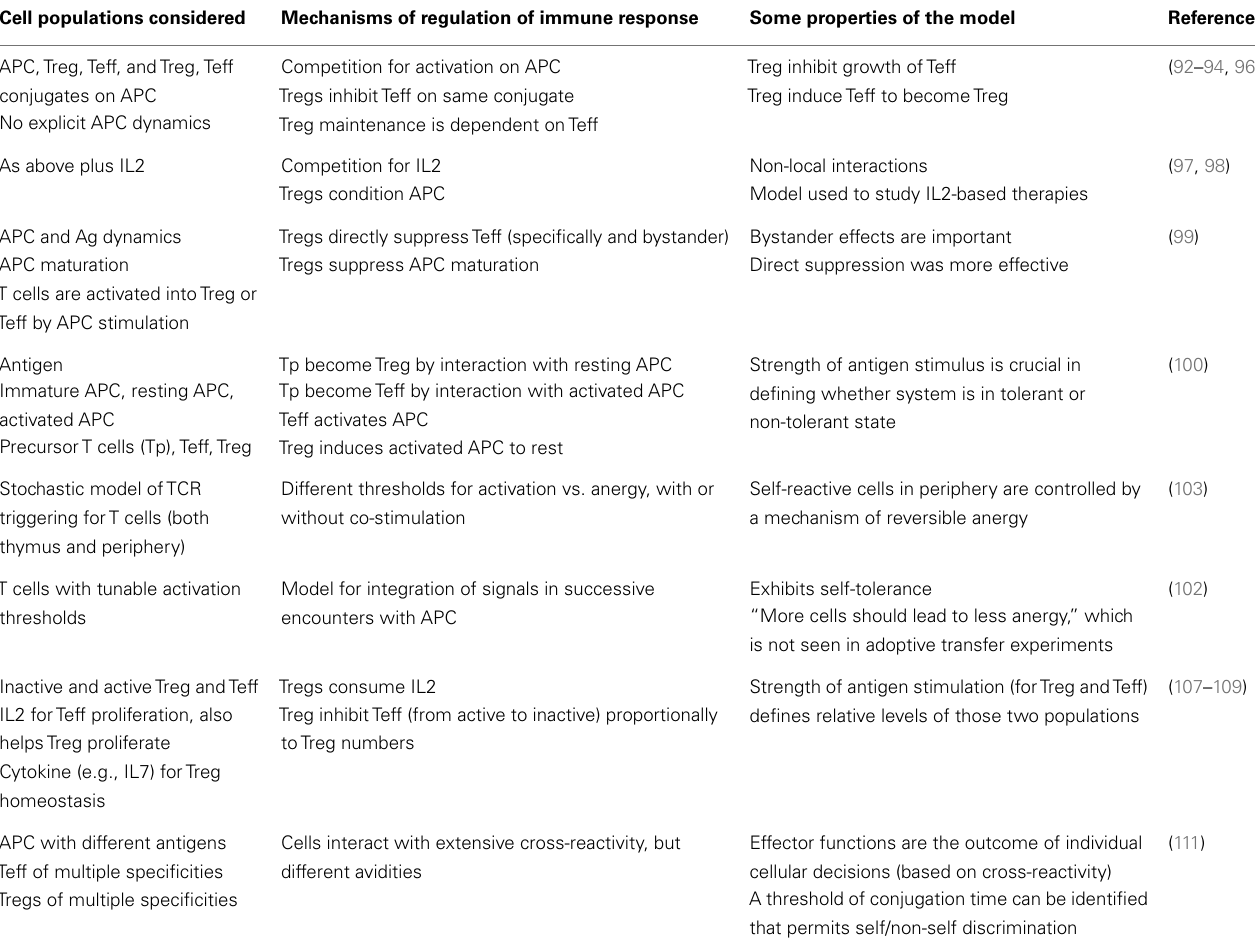
Table 1 | Summary of mechanistic models ofTreg action